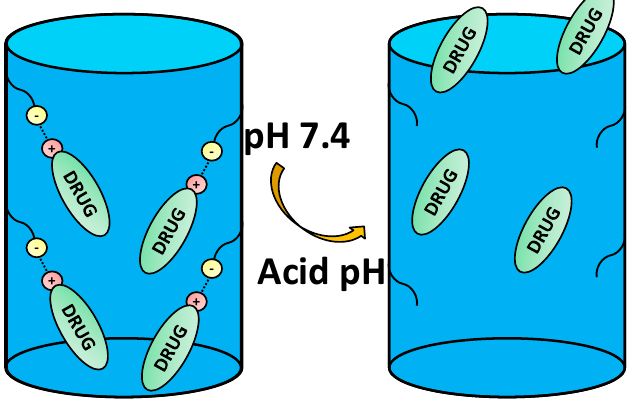
Figure 3. Example of host-guest interaction-based drug delivery involving cationic drugs.